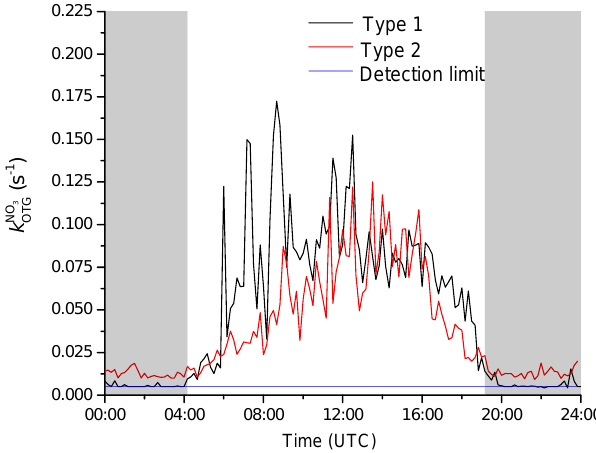
Figure 3. Median diel profile of the NO 3 reactivity. Type 1 nights (black line) show values around the detection limit during night, and type 2 nights (red line) are above the detection